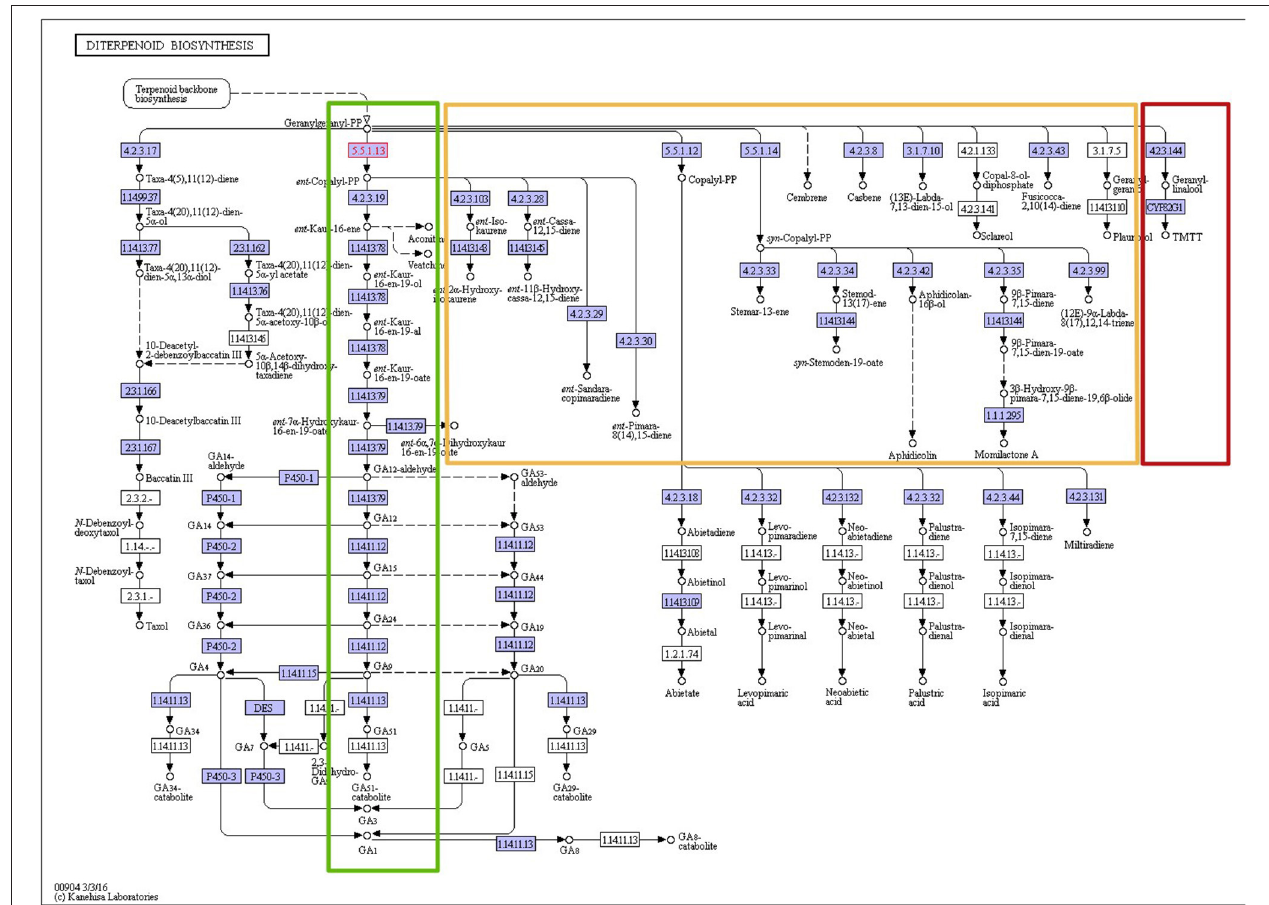
FIGURE 3 | KEGG pathway map of the diterpenoid biosynthesis pathway (map 00904). All enzymes performing the steps of the linear main pathway (highlighted green) were found present in at least 19 plant species. By contrast, the orange-highlighted pathway branches were found present in only one or two species each, and the dark-red highlighted branch was found present in 13 species. Permission to reproduce this pathway map image was kindly granted by the KEGG